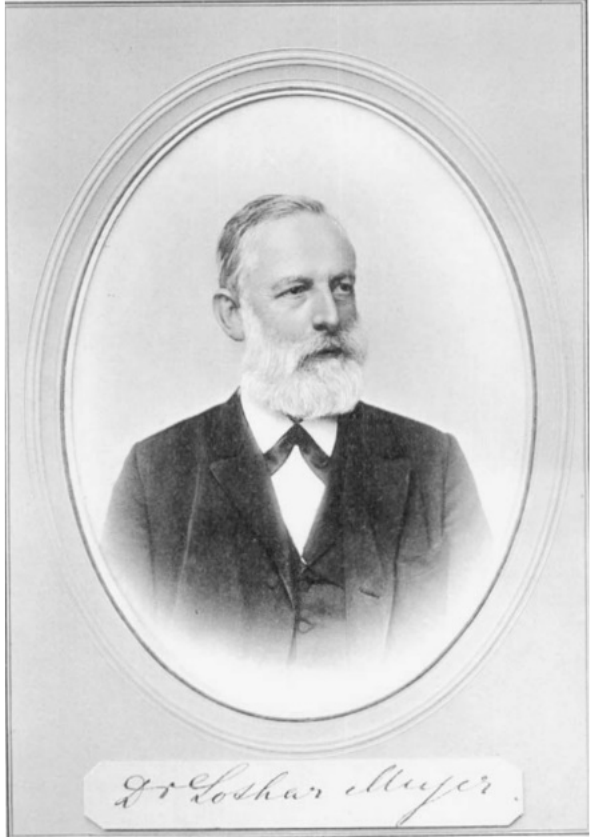
Figure 1. Lothar Meyer. Scan from K. Seubert, Ber. Dtsch.